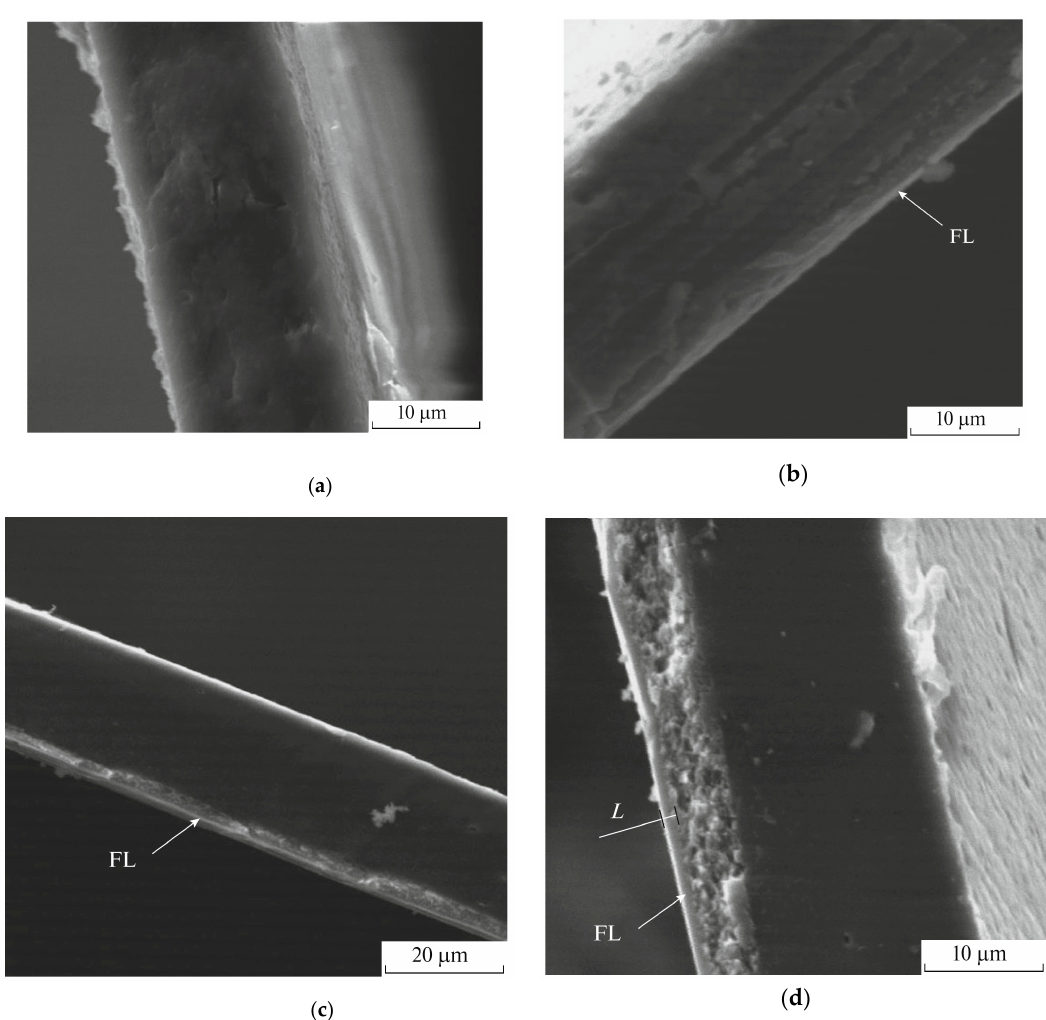
Figure 1. SEM images of ( a ) the virgin acetyl cellulose film and acetyl cellulose films fluorinated for ( b ) 30, ( c ) 60 and ( d ) 120 min. The arrow marks the fluorinated layer (FL). L is the thickness of the fluorinated layer. The figure is adapted from Ref. [65].